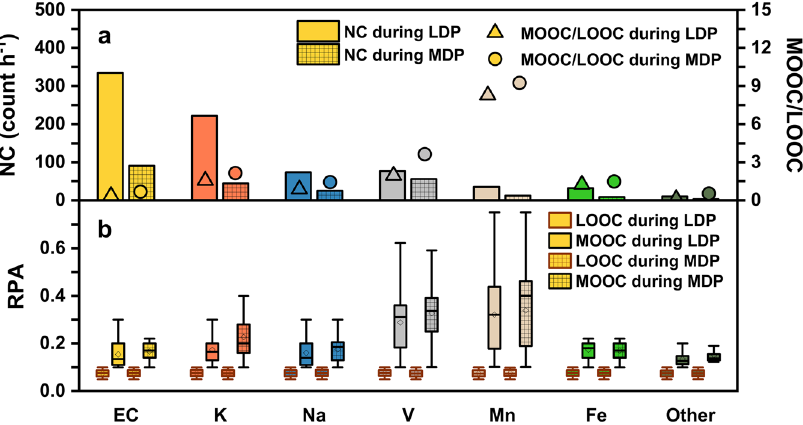
Fig. 2 Single-particle characterization of OOA. a Particle number concentration (NC) and MOOC/LOOC ratio during the LDP and MDP; b relative particle area (RPA) of the OOC markers in the LOOC and MOOC particles in every subgroup during the LDP and MDP. The diamonds indicate the mean values. The line inside the box indicates the median. The box and error bars indicate the 10, 25, 50, 75, and 90th percentiles.